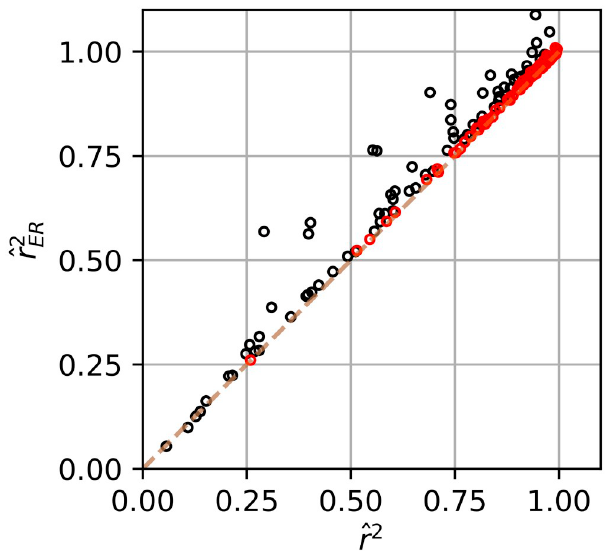
Fig 9. Relationship of naive ^ r 2 and corrected ^ r 2 greater than the median across the population ( d SNR ¼ 3 : 5 ) are plotted in red and those less than or equal to in black.